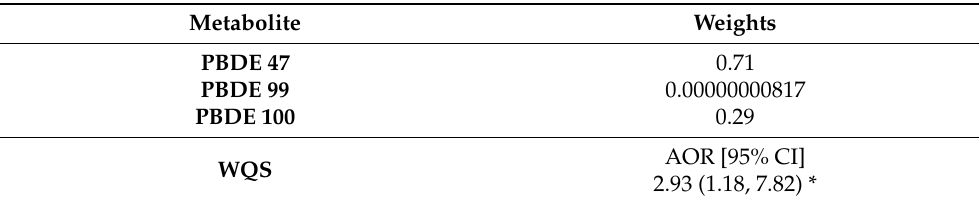
Table 6. Weights of measured PBDEs in association with high antenatal depression risk among African American pregnant women using Weighted Quantile Sum (WQS)